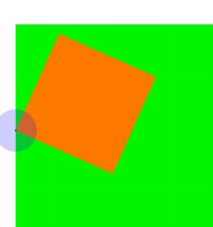
Figure 9: A 2D view of a 3D problematic case where one polyhe-